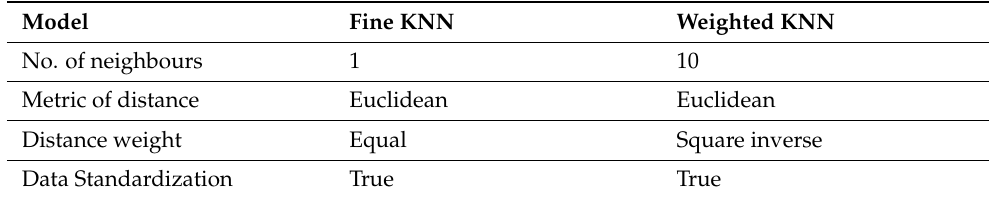
Table 5. Parameters of KNN